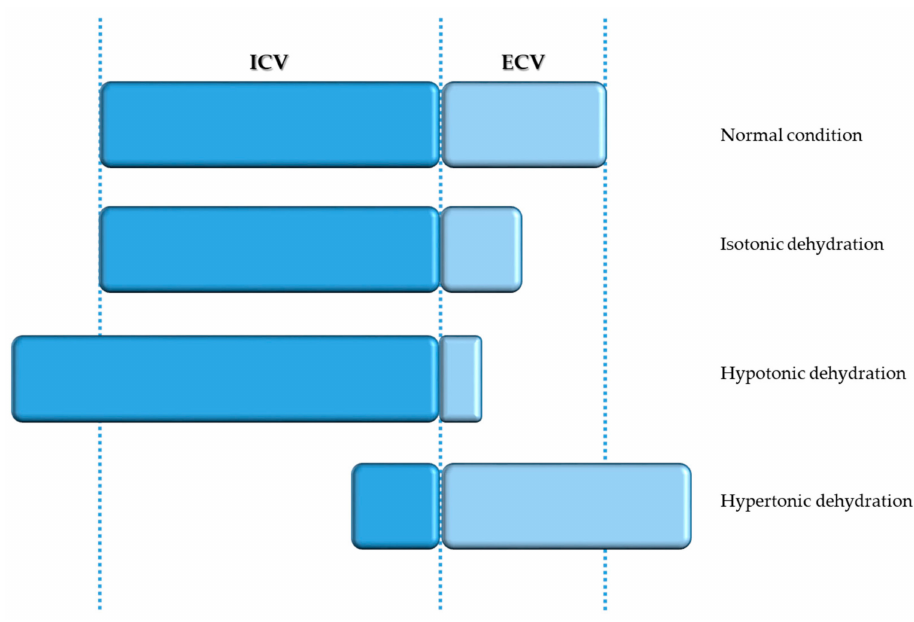
Figure 4. Water balance